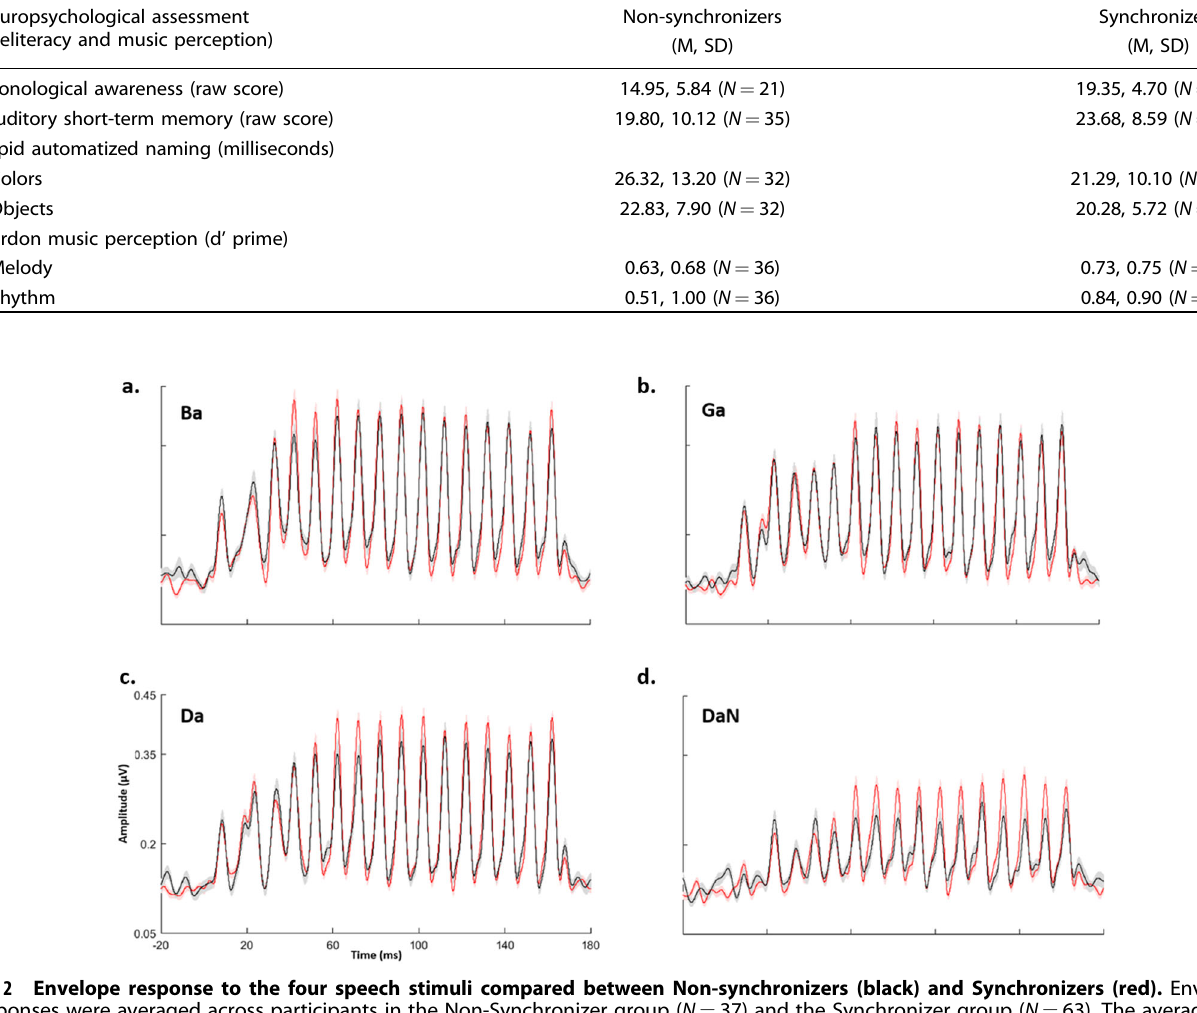
Table 1. Descriptive statistics (Mean, SD) for preliteracy and musical perception measures organized by synchronization group. Neuropsychological assessment (preliteracy and music perception)